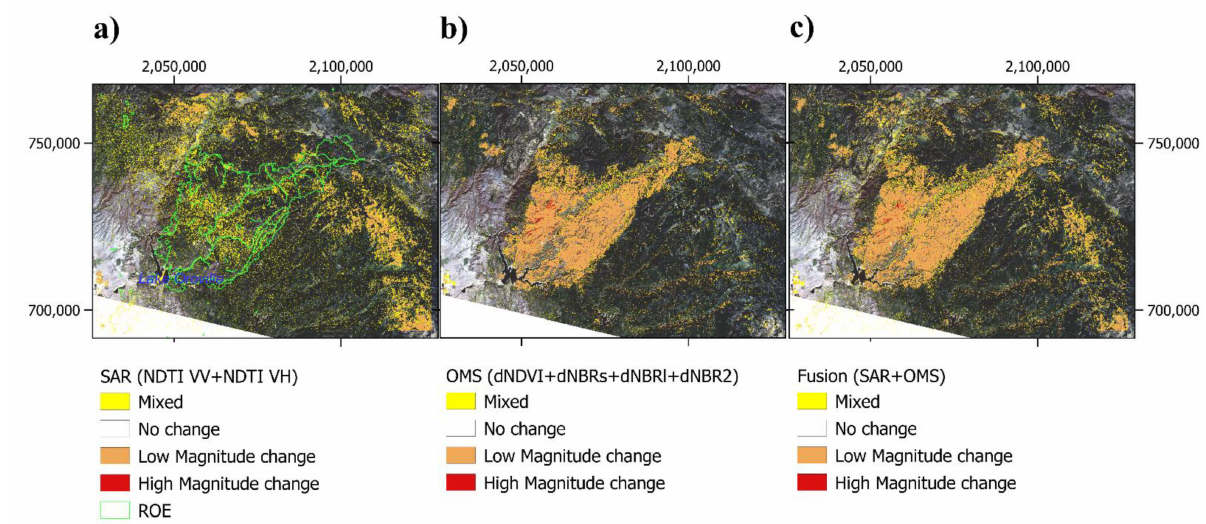
Figure 14. Burned-related change maps for the North Complex case study, obtained from ( a ) the OMS, ( b ) SAR and ( c ) fusion datasets, in comparison to the Reference Observed Event (ROE) [51] (coordinate reference system: NAD83/California zone 2).